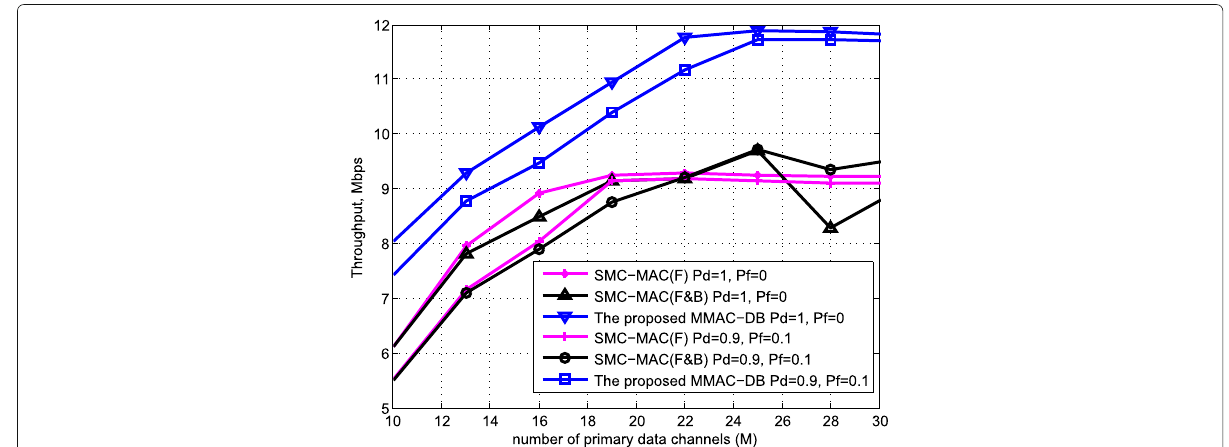
Fig. 9 Throughput comparison with varied M from 10 to 30, N = 20, α = 0.1. Throughput comparison for scene 2